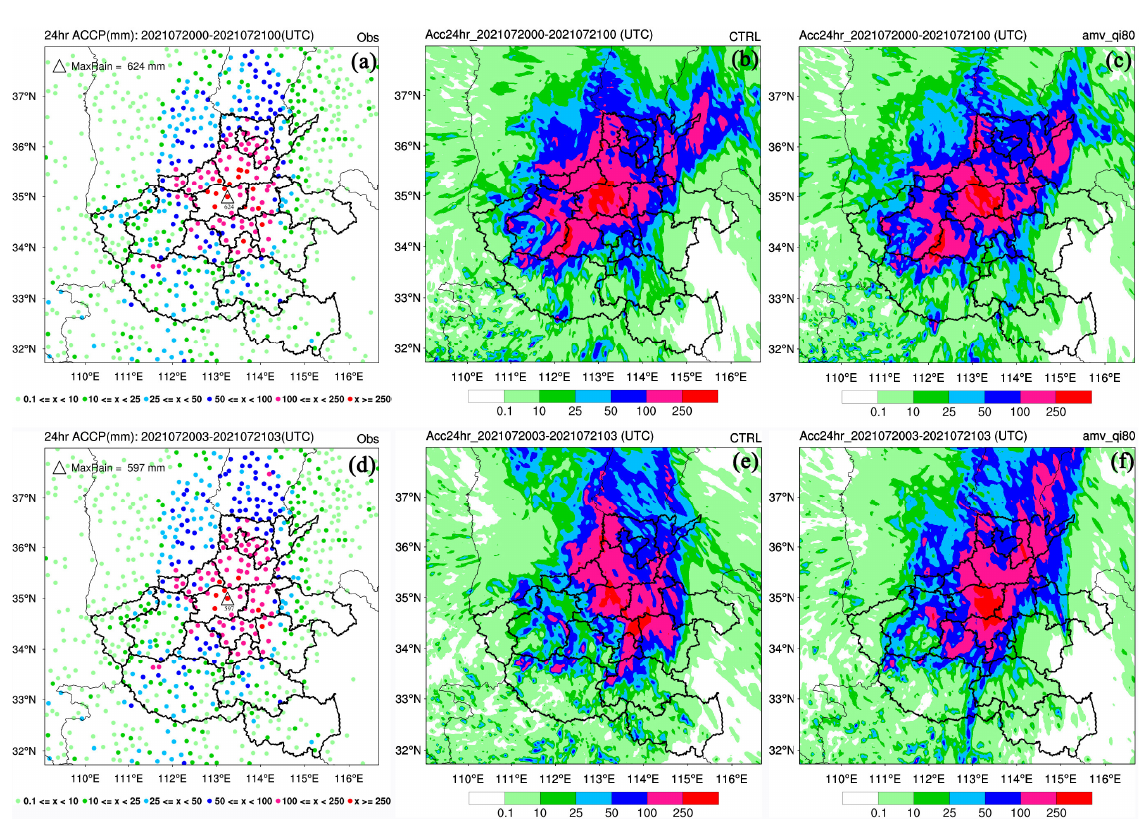
Figure 10. The BIAS score of 6 h accumulated precipitation over the 3 km domain from the three experiments of the CTRL, amv_qi70 and amv_qi80 for the thresholds of 0.1 mm, 1.0 mm, 5.0 mm, 10.0 mm, 25.0 mm and 50.0 mm.